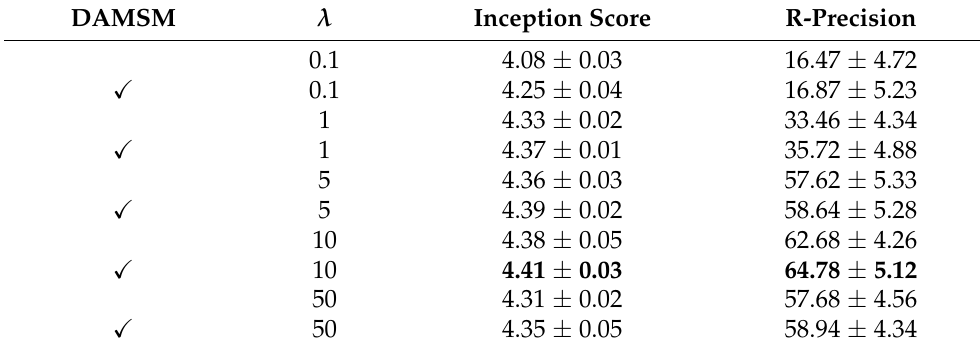
Table 2. The inception score and R-precision in different λ values and whether to use DAMSM.